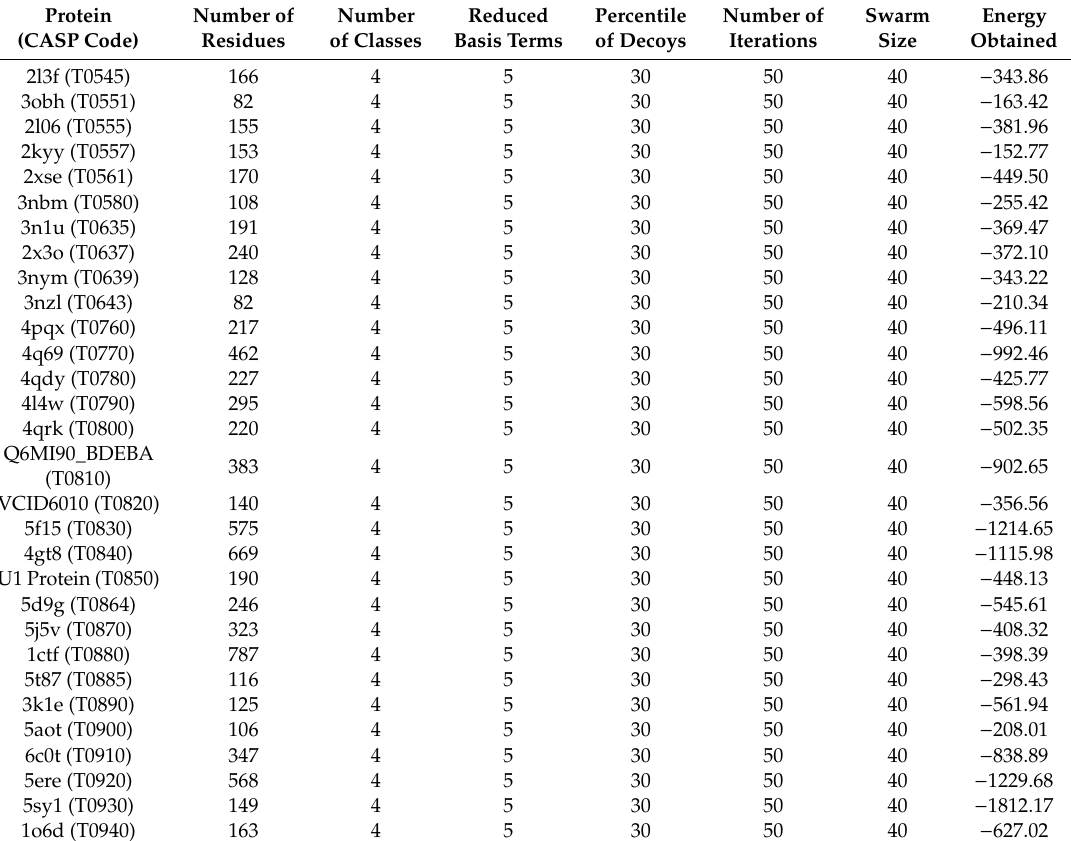
Table 2. Details of the computational experiments performed with the methodology presented in this paper via LDA–SVD and